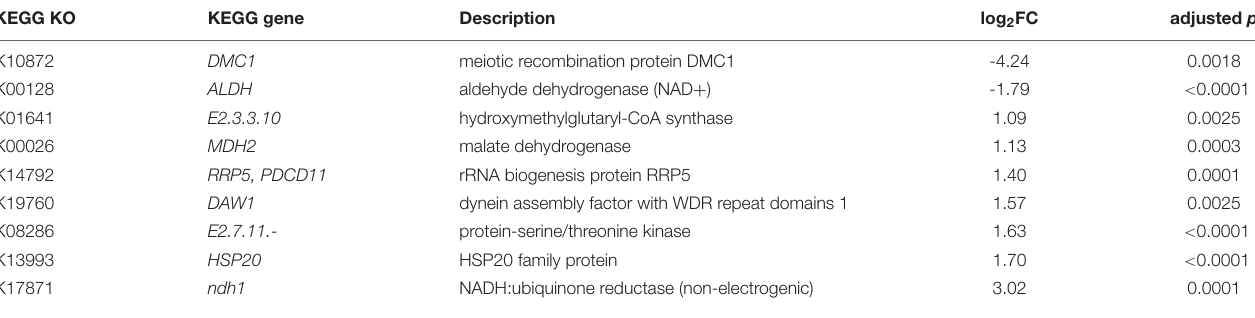
TABLE 5 | Differentially expressed KEGG genes between sporophytes of the two reciprocal crosses among Helgoland and Spitsbergen Laminaria digitata (H × S vs. S × H) at 20.5 ◦ C. KEGG